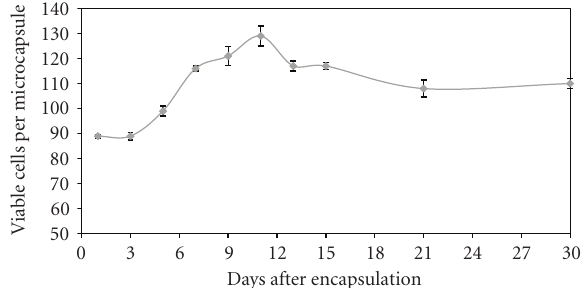
Figure 5: Cell survival and growth kinetics of the Bac-null transduced cells encapsulated in AP-PEG-A microcapsules. For the encapsulation 2 × 10 6 cells/ml of alginate were used and maintained in DMEM + 10% FBS at 37 ◦ C and were incubated for 30 days. Medium was replaced at alternate days. Experimental samples were treated with calcein AM for 1h, and they were measured using fluorescence plate reading at excitation 485 nm, emission